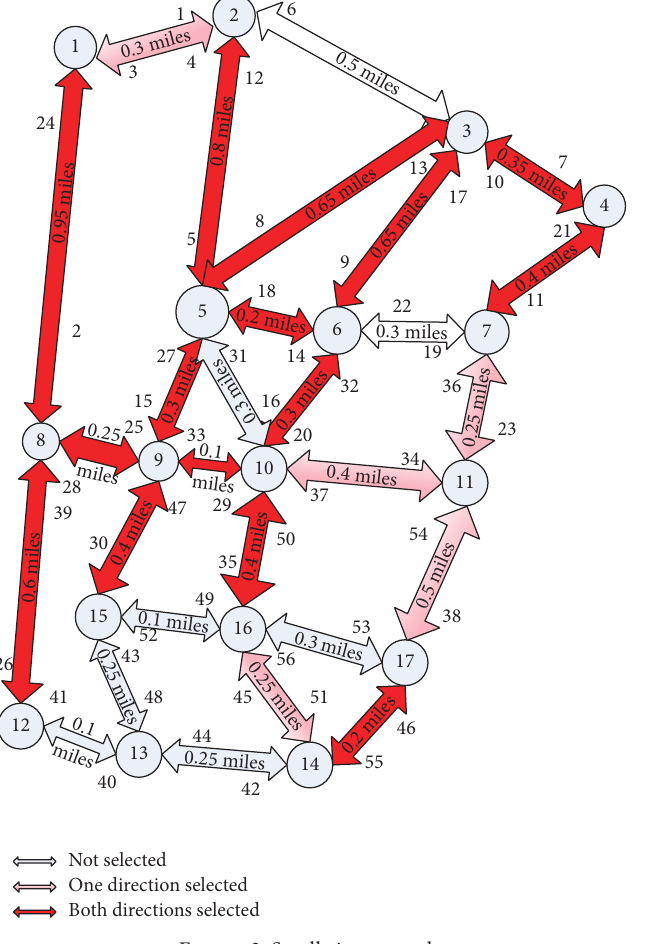
Figure 3: Small city